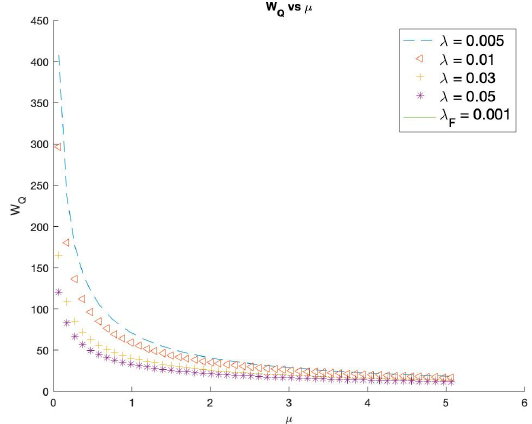
Appl. Sci. 2020 , 10 , x FOR PEER REVIEW Figure 8. Average amount of time in queue ( W Q ) vs rate of slots ( µ ). Figure 8. Average amount of time in queue ( (cid:1849) (cid:3018) ) vs rate of slots ( (cid:2020) ).